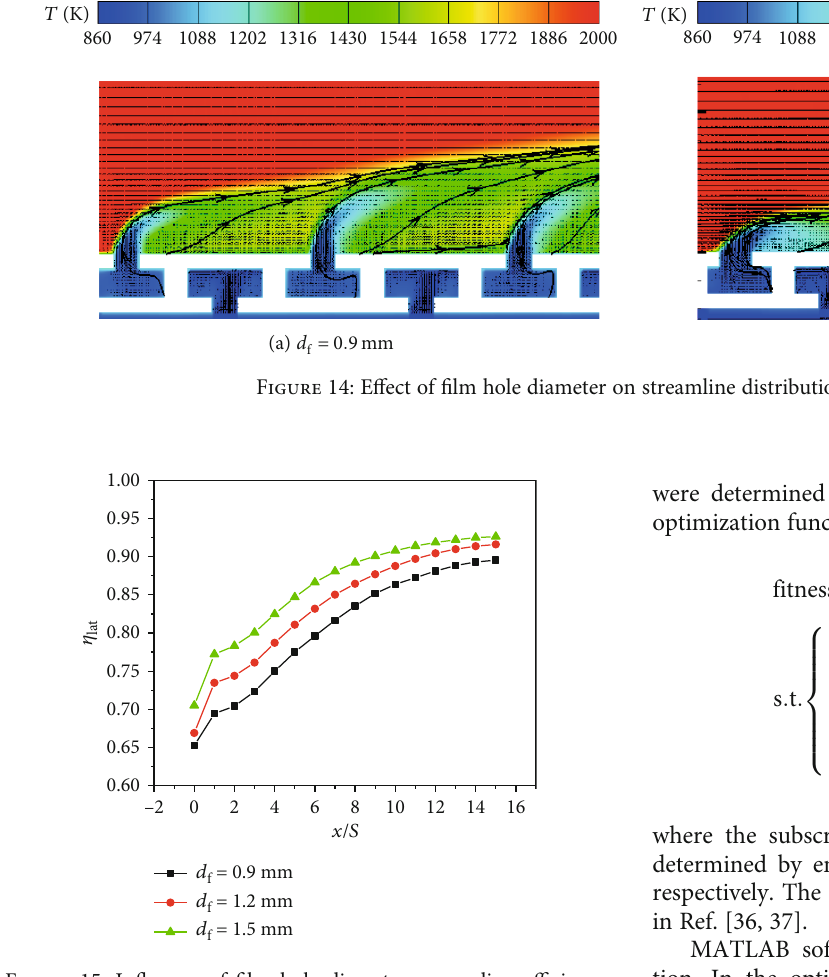
Figure 15: In fl uence of fi lm hole diameter on cooling e ffi ciency